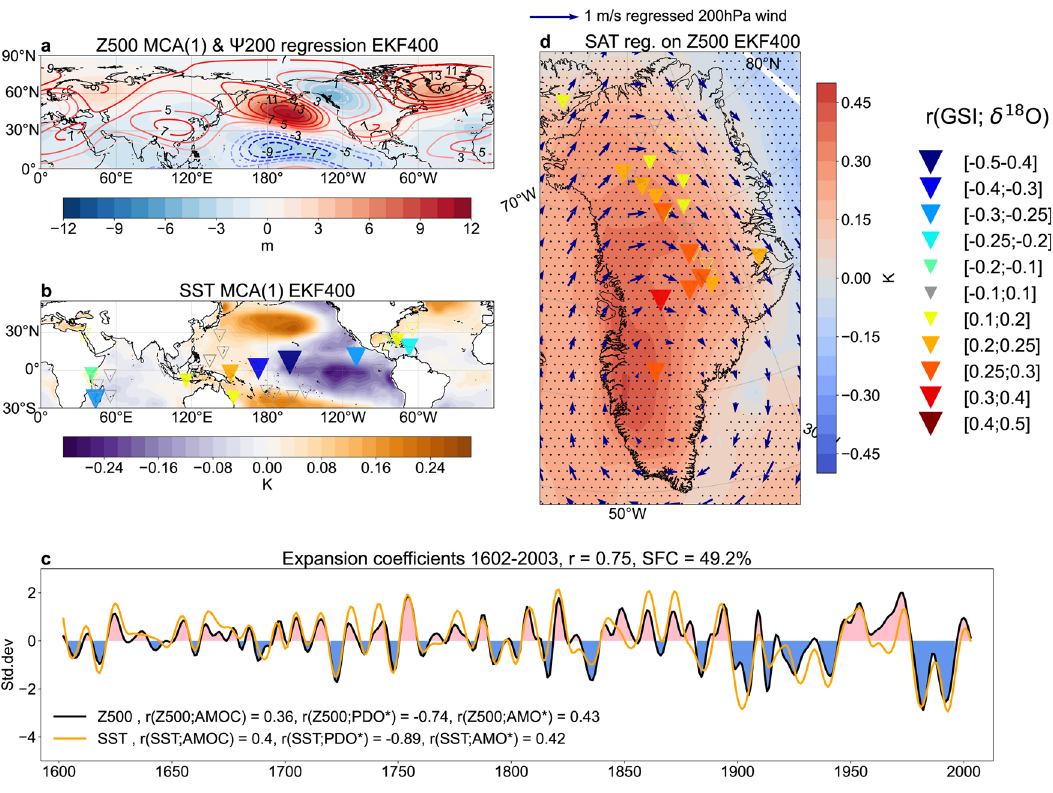
Fig. 5 | The temporal consistency of the observed teleconnection in fl uencing Greenland over AD 1602 – 2003 as simulated by the EKF400. Spatial patterns corresponding to the leading internal mode of co-variability between Northern Hemisphere annual mean a 500hPa geopotential height (Z500) and b sea surface temperatures (SST) (30°S – 55°N) and c the corresponding expansion coef fi cients (EC, shown as units of standard deviations) for Z500 (blue) and SST (orange) as revealedbymaximumcovarianceanalysis(MCA,Methods)intheEnsembleKalman Filter (EKF400) paleo-reanalysis over 1602 – 2003. The ECs are fi ltered with a 10yr lowpass fi lter to elucidate decadal variability. The shared fraction of covariance (SFC)is49.2%,thecorrelationbetweentheECsisr=0.75.Thearea-weightedglobal meanisremovedbeforeMCAfromZ500andthe60°S – 60°NmeanfromSST.Panel c also shows the correlations between the (non- fi ltered) ECs and an Atlantic Mer- idional Overturning Circulation (AMOC) reconstruction 54 and the EKF400-derived